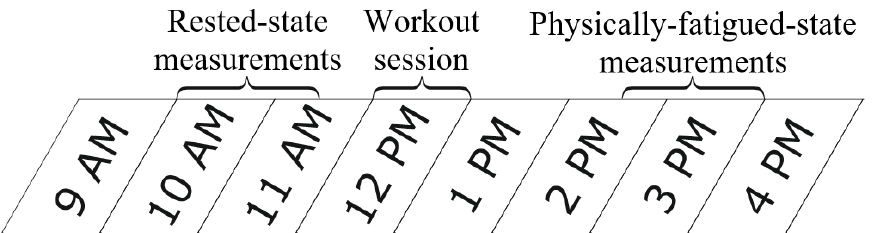
Figure 1. Overview of an experiment day. Cardiovascular and reference parameters were measured similarly in both test sets. The workout session involved multiple full-body